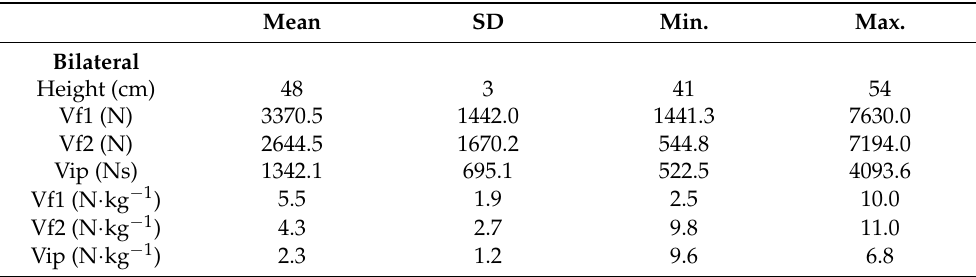
Table 2. Drop Jump Test (bilateral and unilateral) related biomechanical kinetic descriptive values. Mean SD Min.